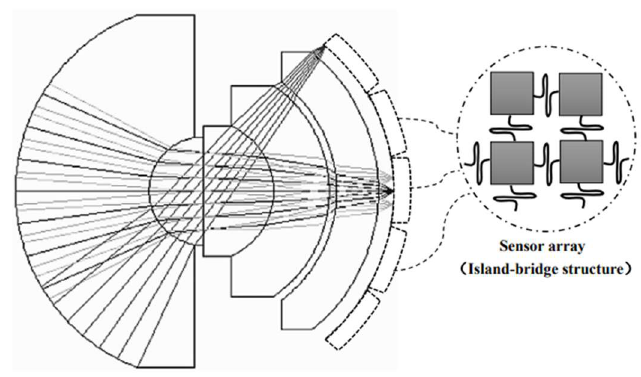
Figure 5. Sensor array diagram.